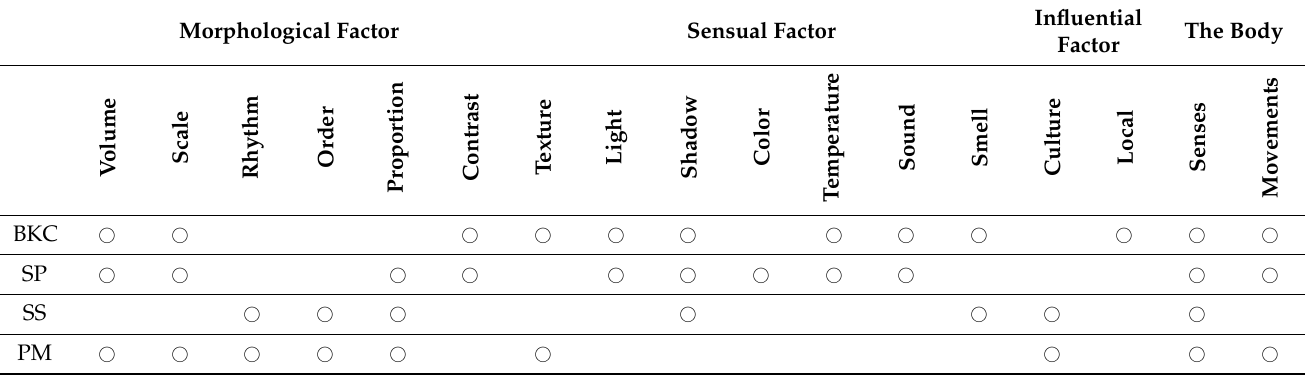
Table 3. Analysis of various aspects of spatial experience for emotional connection. Source: au- thor’s